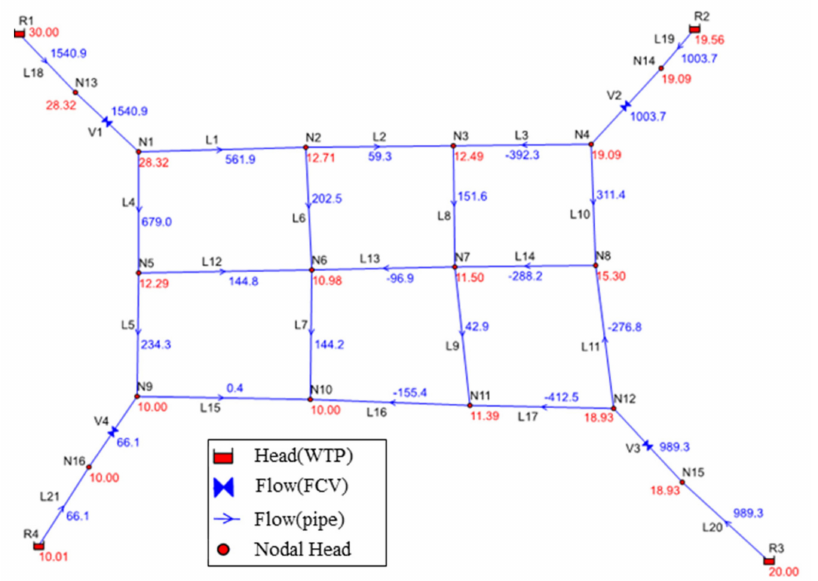
Figure 5. Hydraulic distribution of the network based on the optimization results of the local search